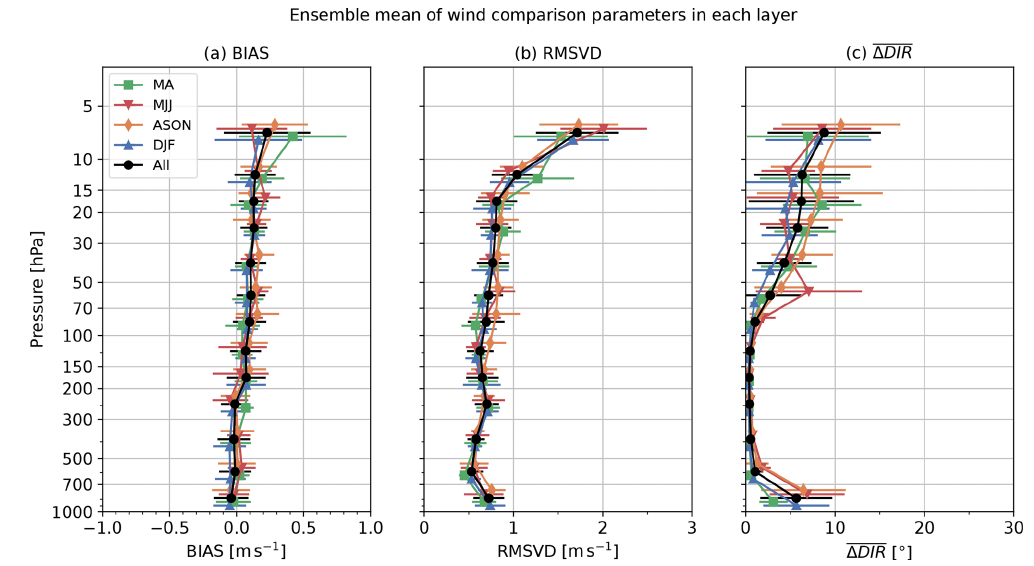
Figure 29. Seasonal wind difference parameters with colouring, as per Fig. 18b. (a) BIAS. (b) RMSVD. (c) (cid:49) DIR.